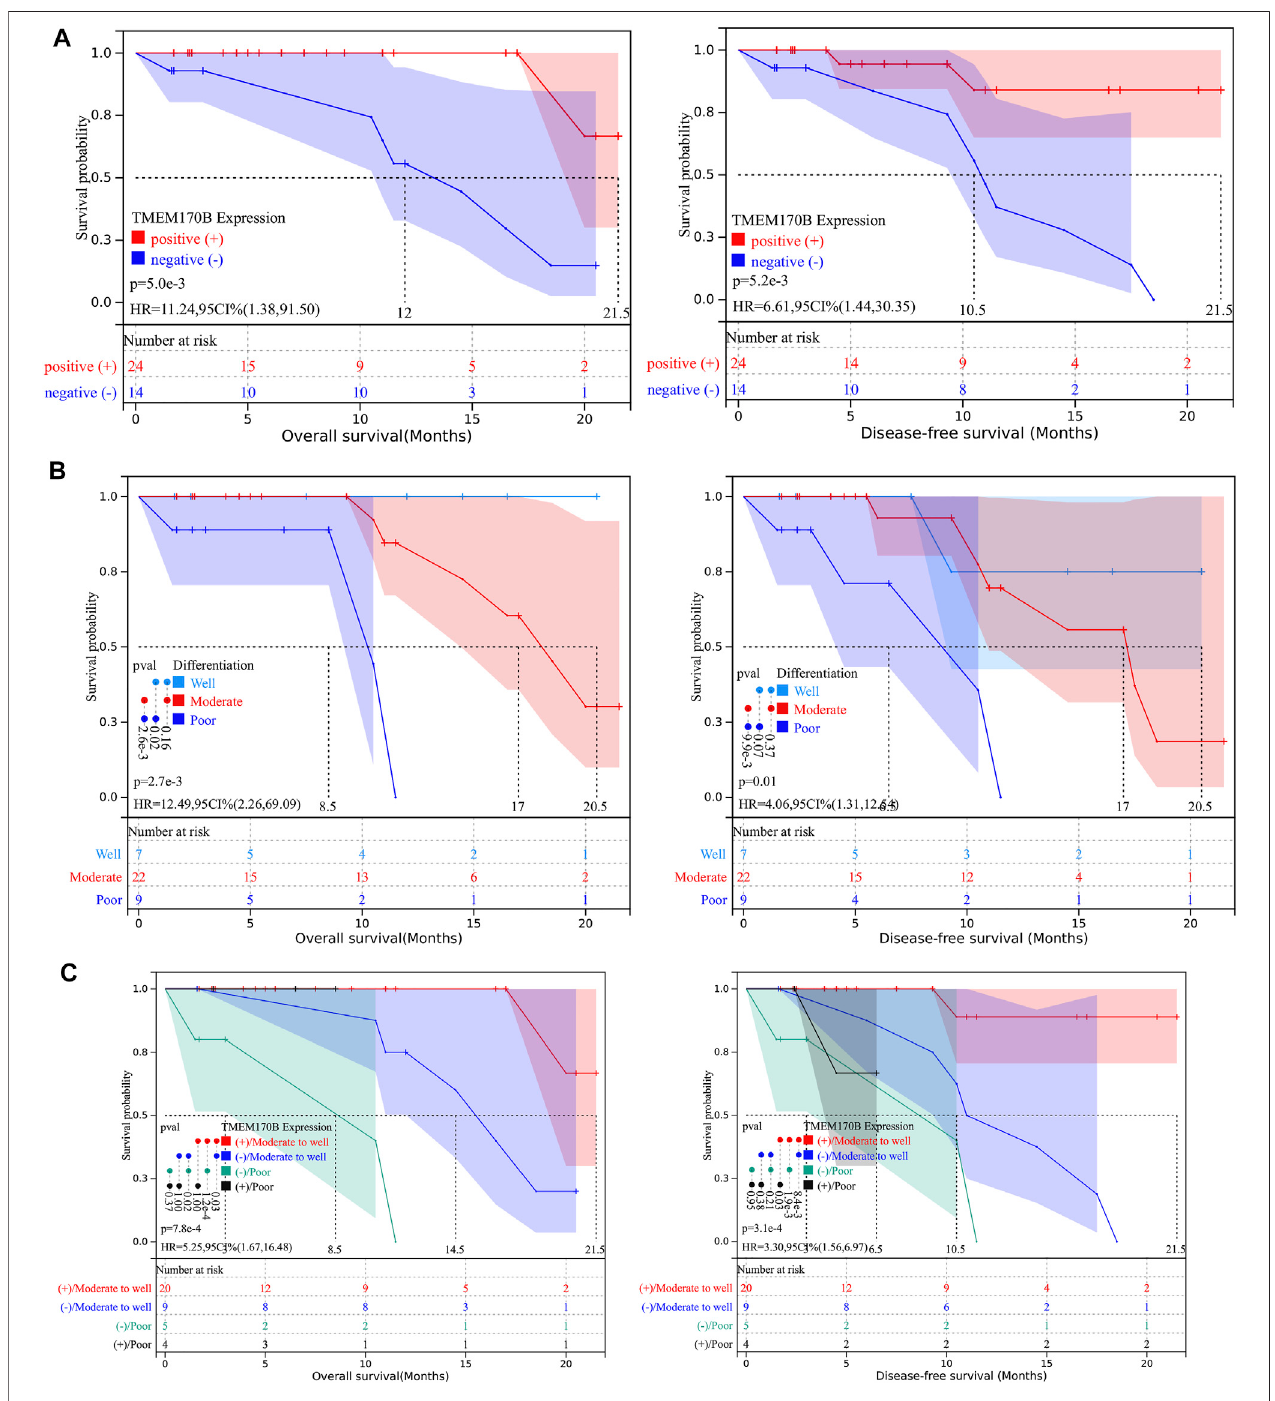
FIGURE 5 | TMEM170B expression and the degree of differentiation correlated with survival outcomes in our cohort. (A) Low TMEM170B expression was signi fi cantly associated with poor clinical outcomes. (B) The outcomes in the poor differentiation group were worse than those of the moderate and high differentiation groups. (C) Association of TMEM170B expression with the outcomes in poor differentiation or moderate to high differentiation: Subgroup analysis.